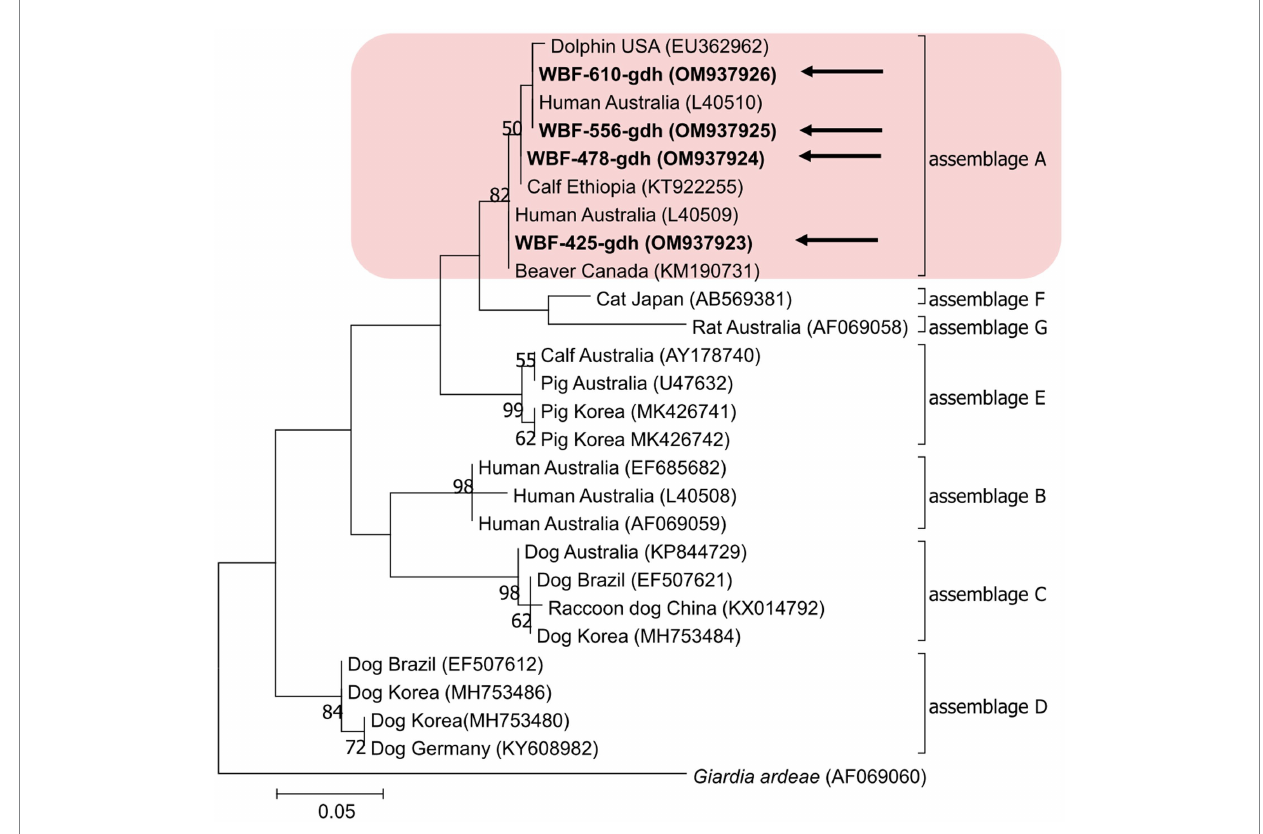
FIGURE 4 Phylogenetic tree of Giardia (gdh) isolated from Korean wild boars. The sequences obtained from the phylogenetic analysis based on the Giardia gdh gene are indicated in